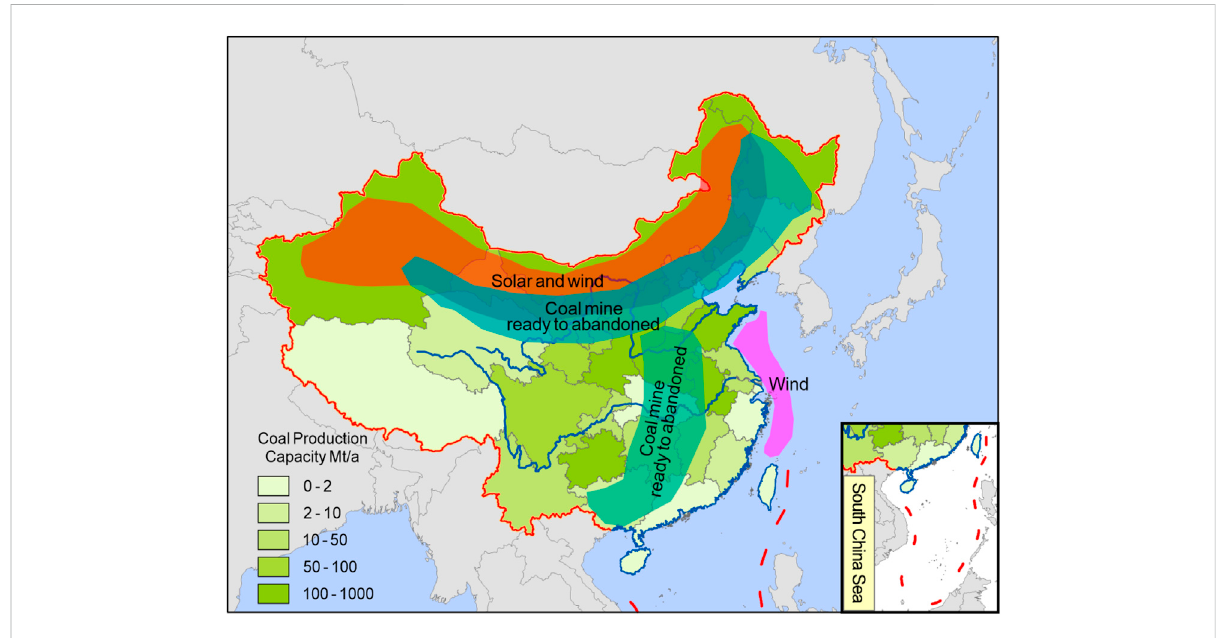
FIGURE 2 Distribution of coal production capacity and renewable energy.